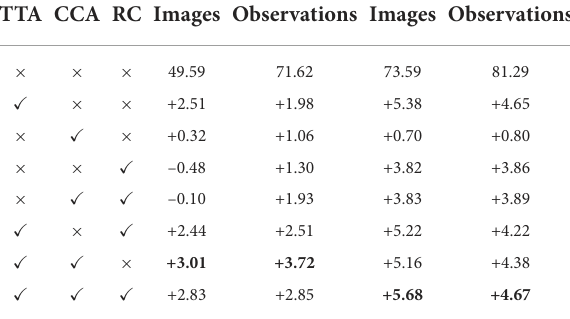
TABLE 5 Ablation study considering different techniques for ViT-Base/32 performance improvements.